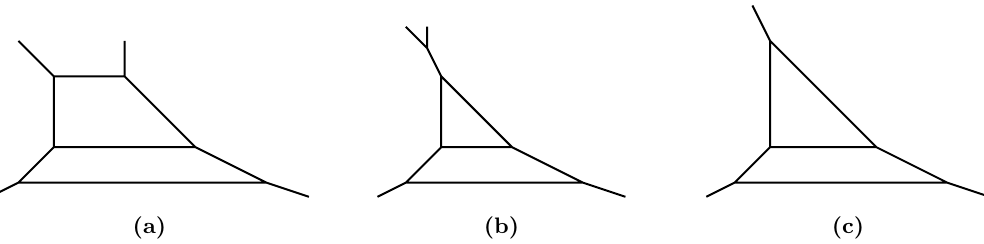
Figure 3. A 5-brane web construction for P 2 ∪ F 3 . Starting from the web diagram of SU(3) 2 theory (a), flop transition for an instantonic hypermultiplet gives (b). Integrating out the hypermultiplet gives a web diagram of P 2 ∪ F 3 depicted in (c).